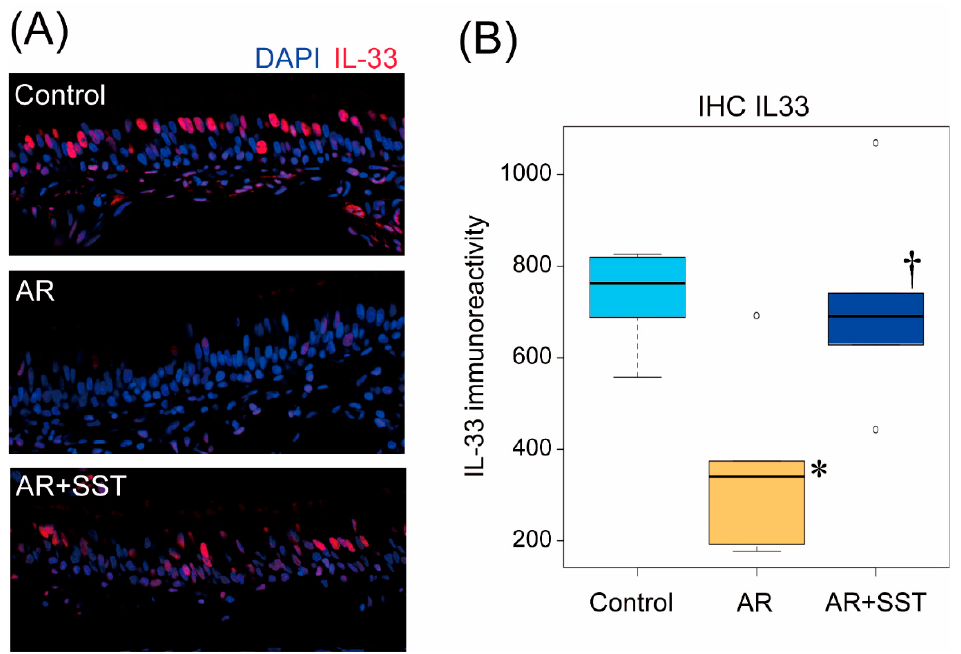
Figure 4. SST inhibited the release of IL-33 from nasal epithelial cells induced by the TDI-induced provocation. ( A ) Representative images of mucosal tissue from the nasal cavity stained with anti-IL-33 antibody. Red: IL-33, Blue: DAPI. Bar = 50 µ m ( B ) Quantified data for immunoreactivity of IL-33 in the tissue. (n = 5) * p < 0.05 Control group; † p < 0.05 vs. AR group. (One-way ANOVA followed by Tukey’s multiple comparisons).